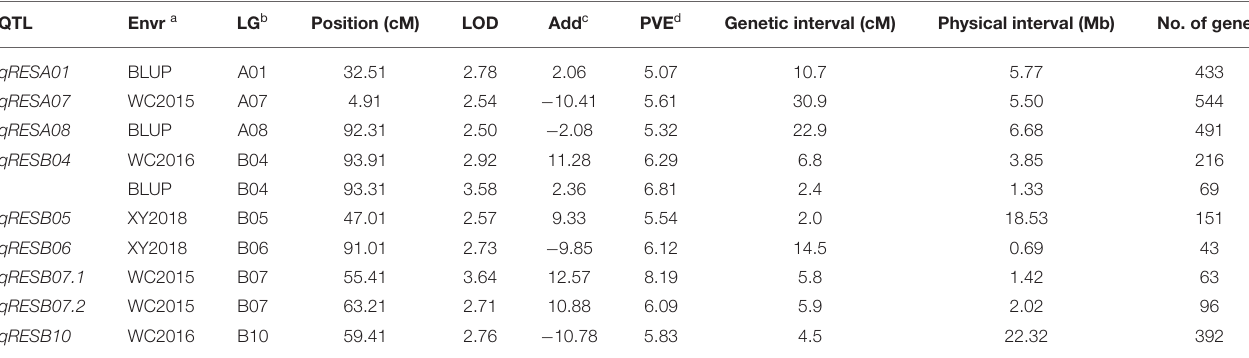
TABLE 3 | Summary of QTL identified for resveratrol contents in the RIL populations across four environments. QTL Envr a LOD Add c PVE d Genetic interval (cM) Physical interval (Mb) No. of